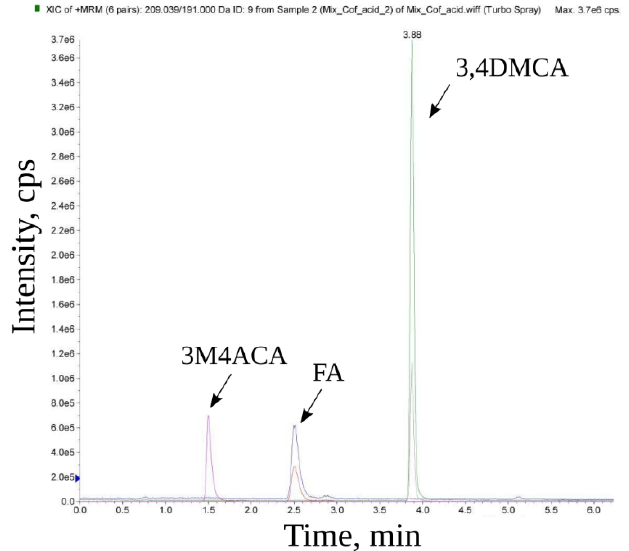
Figure 1. Chromatograms of the MRM transitions corresponding to the three cinnamic acid deriva- tives: 3-methoxy-4-acetamidoxycinnamic (3M4ACA), ferulic (FA), and 3,4-dimethoxycinnamic (3,4DMCA) acids. Two MRM transitions for each compound are shown in the chromatograms. The area of the chromatographic peak is proportional to the concentration of the substance; for the quan- used for reliable identification of the compound.